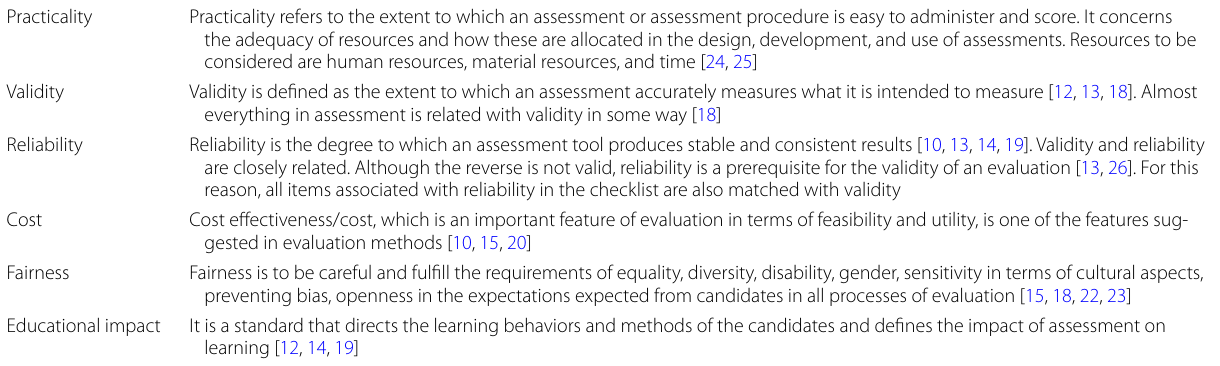
Table 2 Assessment standards for assessment procedures